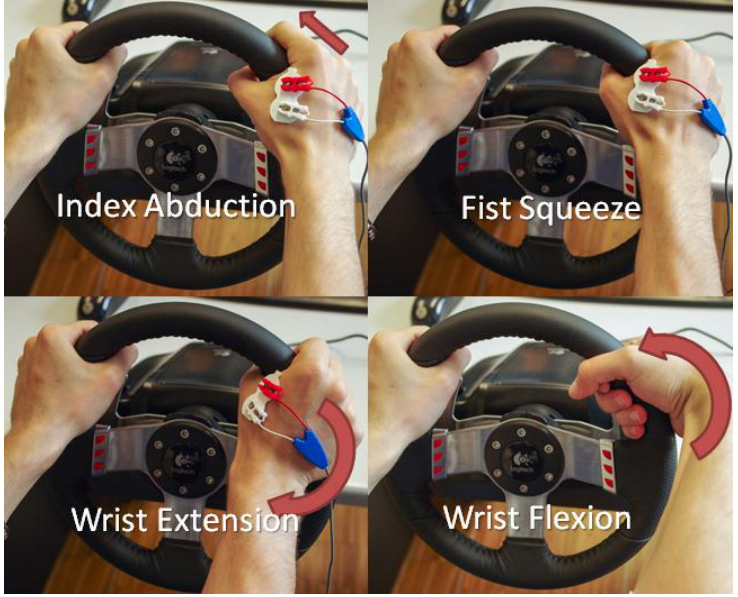
Figure 6. The four gestures for the wearable WheelSense